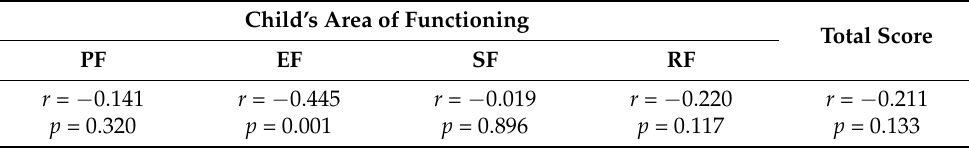
Table 4. Pearson’s correlation coefficients for children’s age and